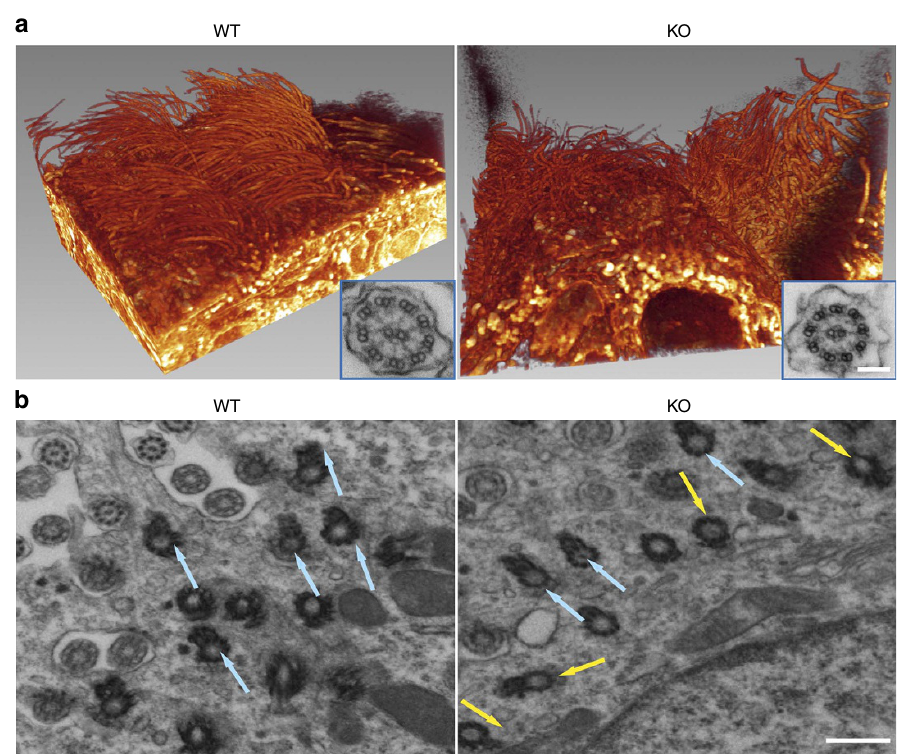
Figure 3 | Motile cilia of lateral wall in Alix (cid:2) / (cid:2) brain show defective orientation. ( a ) 3D reconstruction of whole-mount scanning electron microscopy (SEM) images of WT ( n ¼ 3) and Alix (cid:2) / (cid:2) ( n ¼ 3) lateral wall. Inset: the typical 9 þ 2 axoneme structure is maintained in Alix (cid:2) / (cid:2) cilia. Scale bar, 100 m m. ( b ) Transmission electron microscopy (TEM) of the basal bodies in WT and Alix (cid:2) / (cid:2) ependymal cells ( n ¼ 2). Arrows indicate orientation of the basal bodies. Scale bar,